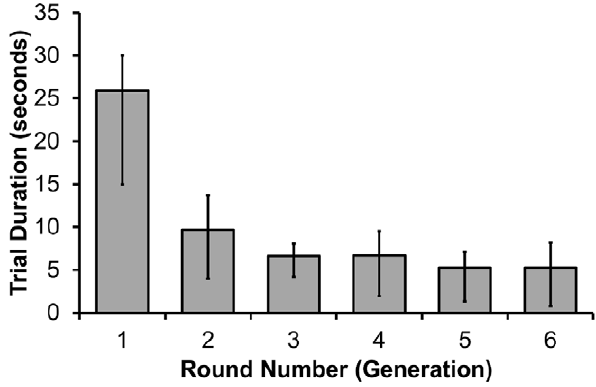
Figure 3. Trial duration over rounds. Median trial duration over rounds 1–6, correct target trials only. Error bars show first and